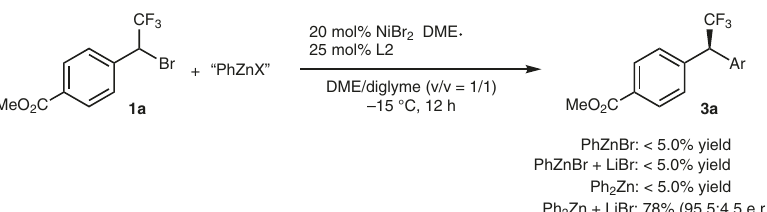
Fig. 3 Control experiments. The effects of different nucleophiles